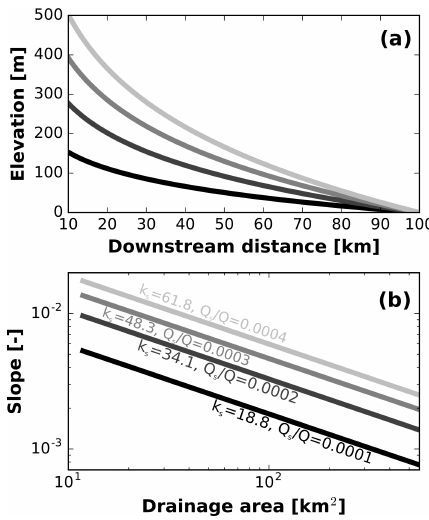
Figure 5. As the sediment-to-water discharge ratio increases, a steeper channel is required to mobilize the sediments, and as a re- sult, the channel steepness index ( k s , Eq. 51)